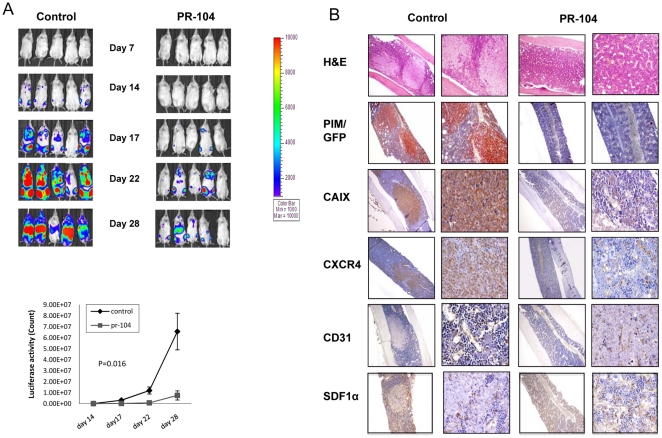
PR-104 administration resulted in decreased tumor burden and hypoxic areas in a Nalm6/GFP ALL model.NSG mice injected with Nalm6-GFP/Luciferase cells were treated with PR-104 starting on day 3 after injection (250 mg/kg, i.p. 3 times a week for 2 weeks). PIM was administered 3 hours prior to sacrifice. (A) Luciferase activity in PR-104-treated and control mice over the course of the experiment. Bottom graph: Luciferase quantification of control and PR-104 treated mice. (B) BM sections from control and treated mice stained for the hypoxia markers PIM and CAIX and for GFP, CXCR4, CD31 and SDF1α. Original magnification, ×100 and ×400 (H&E) ×40 and ×400 (PIM/GFP, CAIX, CXCR4, CD31 and SDF1α).